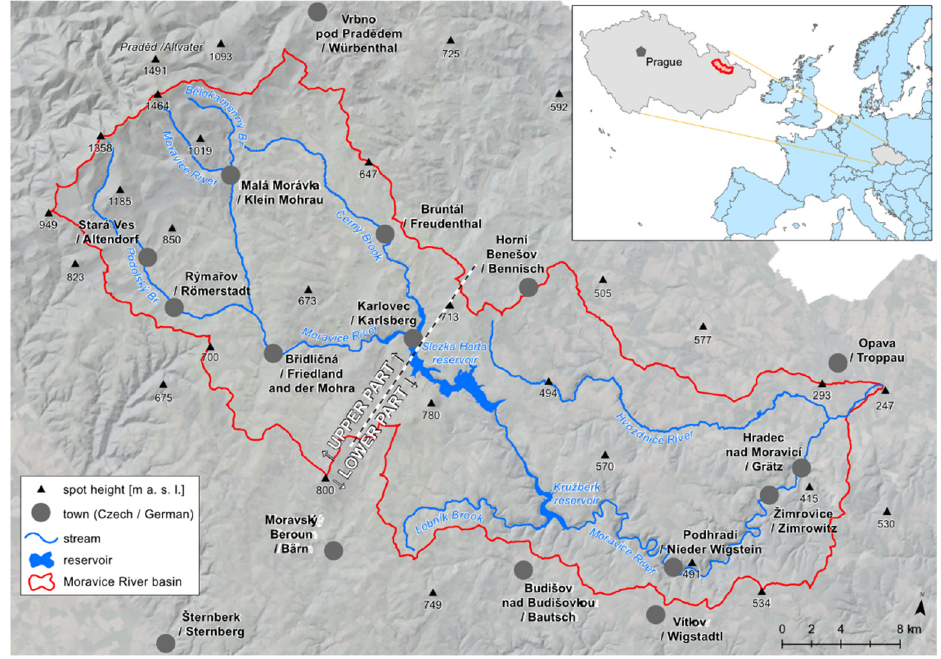
Figure 1. An overview map of the Moravice river basin.